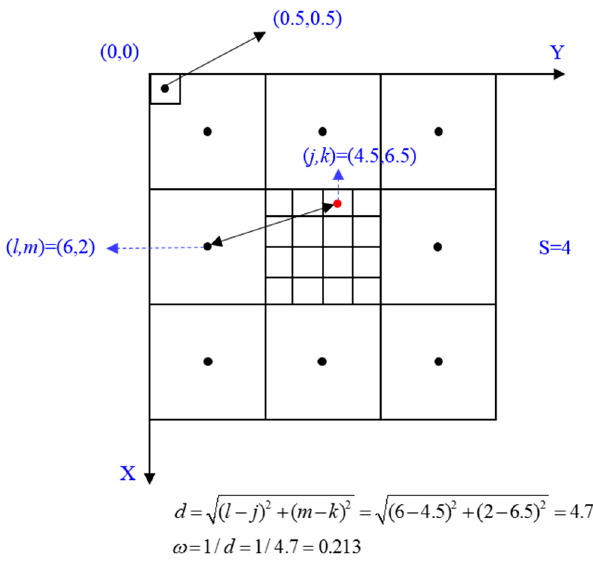
Figure 3. The sub-pixel coordinate system and distance calculation between pixel and sub-pixel.